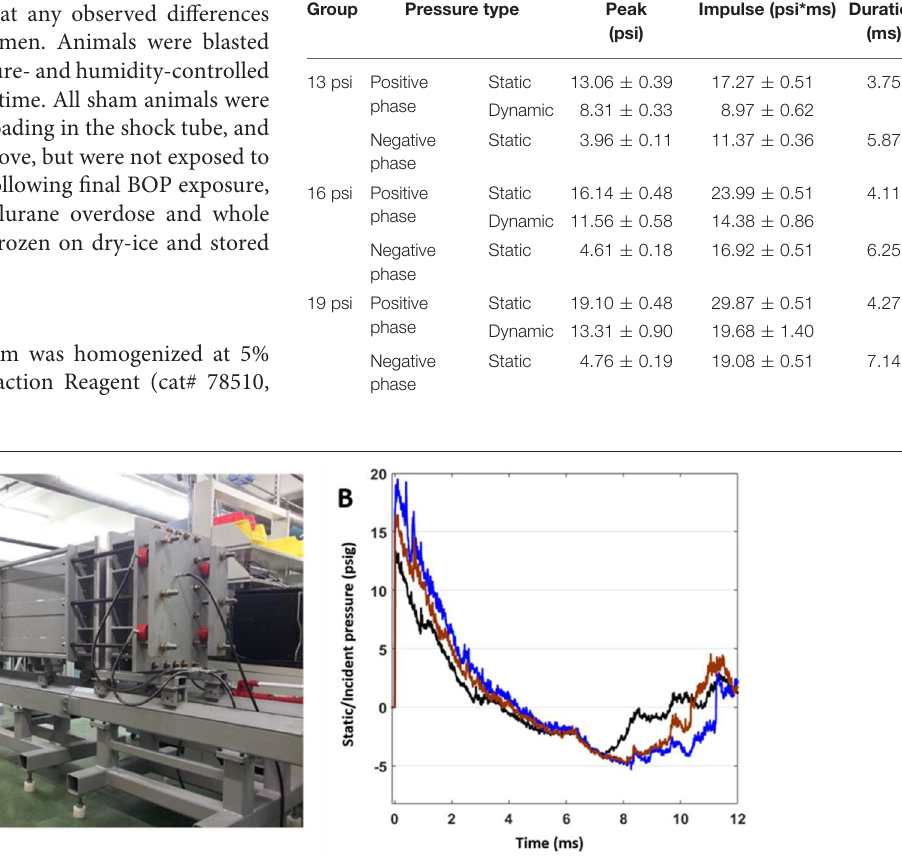
FIGURE 1 | (A) The advanced blast simulator (ABS) located at Walter Reed Army Institute of Research (WRAIR), used to produce experimental blast. (B) Pressure profiles generated using the ABS, which has both positive and negative phases and mimics “free-field” blast for the 13 (black), 16 (brown), and 19 psi (blue) treatment